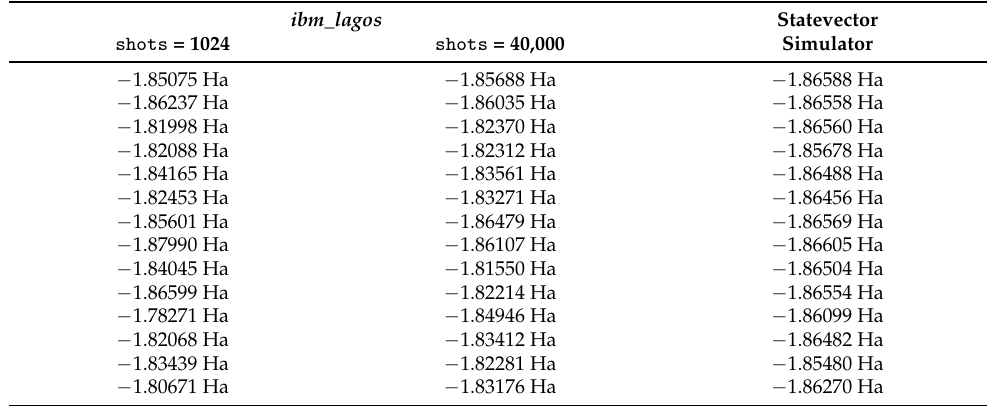
Table A6. Energy values obtained by ibm _ lagos with various final energy evaluations. These data are the basis for Figure